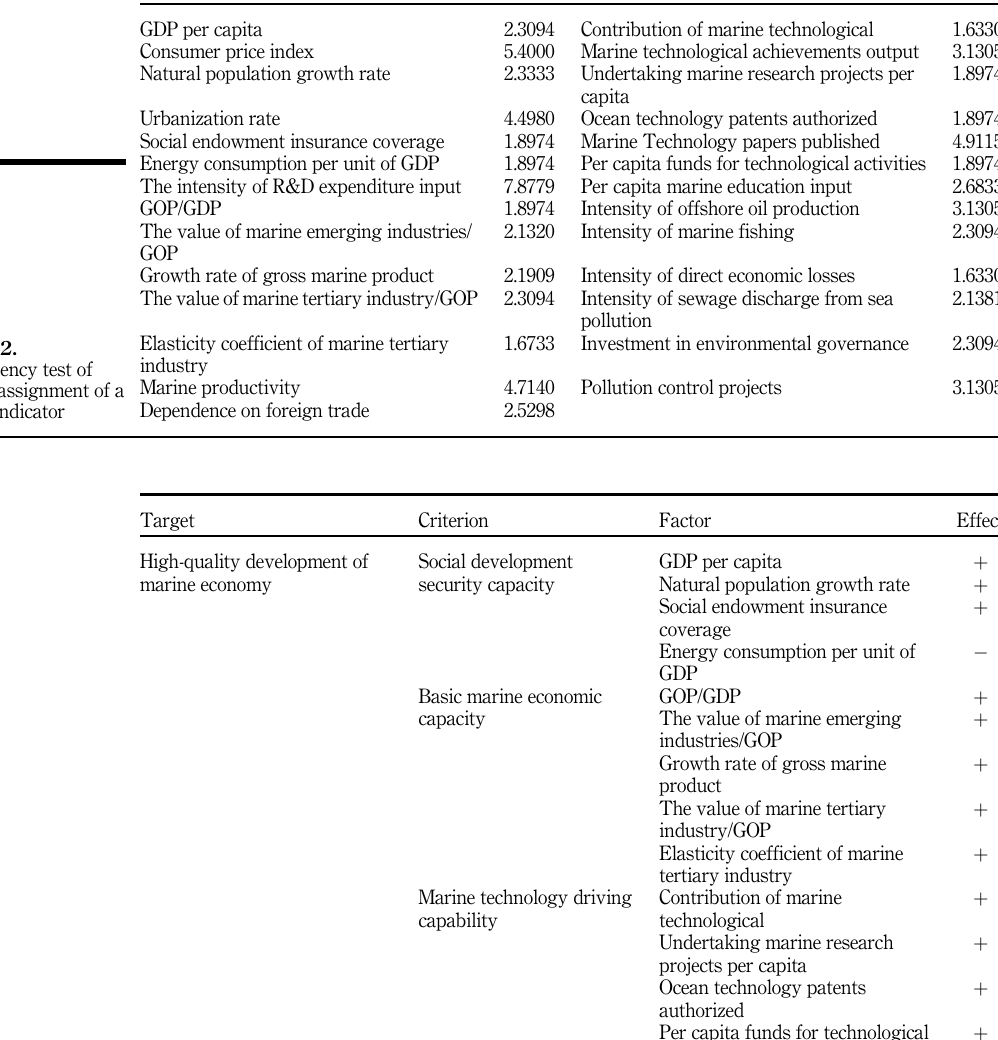
Table 3. Indicator system of high-quality development of marine